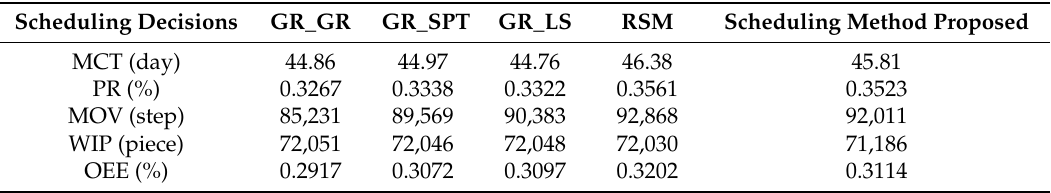
Table 2. The average of production performance indicators under different scheduling methods.